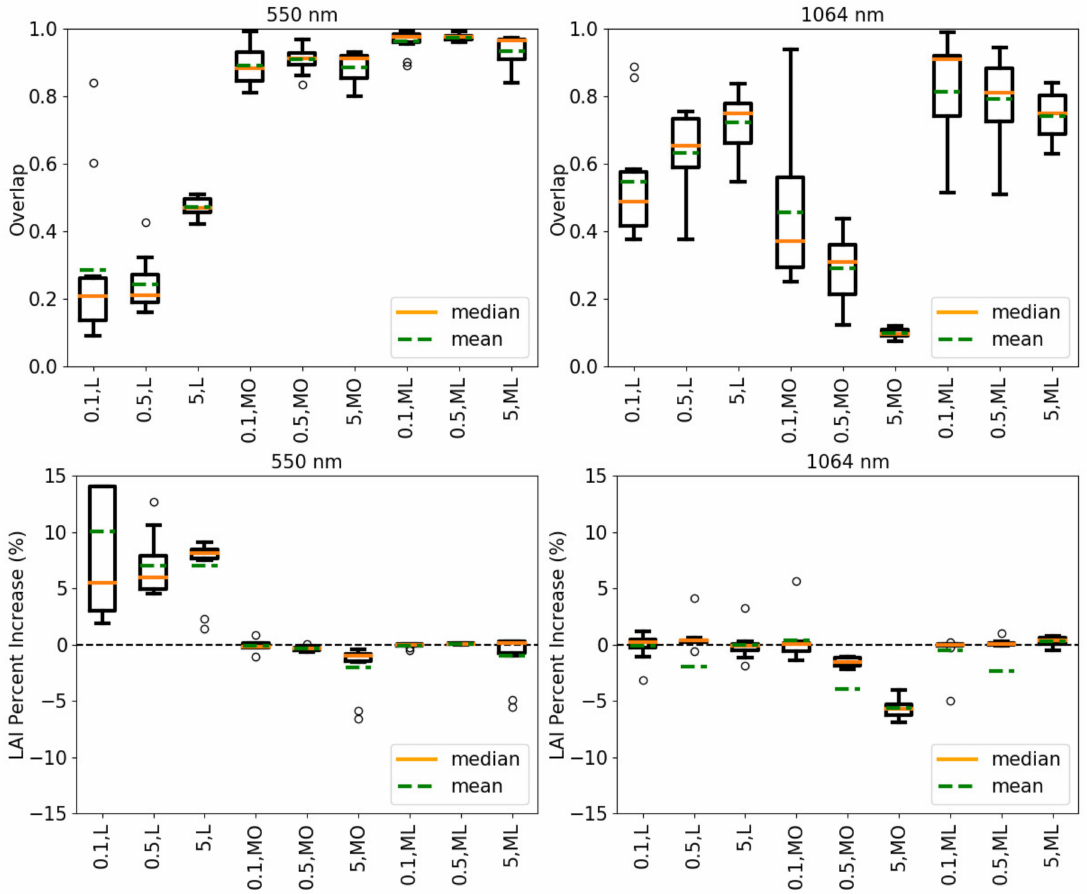
Figure 18. Box plots of the percent increase, waveform overlap, and LAI percent increase metric (rows top-to-bottom) for the 550 nm wavelength (left column) and the 1064 nm wavelength (right column). The plots encompass the ten interrogation sites for each of the three lidar footprints (0.1, 0.5, and 5